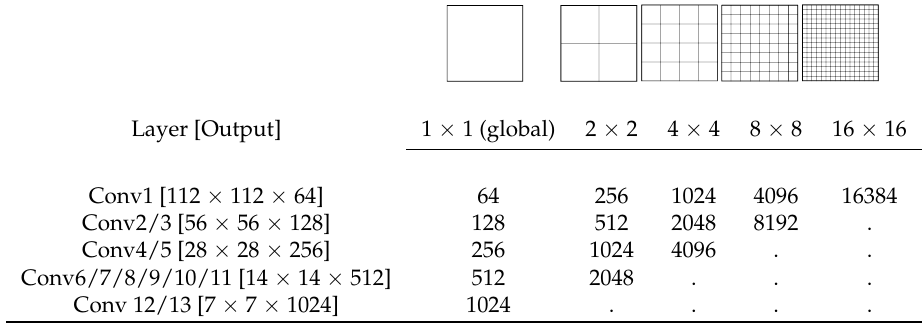
Table 3. Resulting dimensionality of grid pooling strategies on convolutional layers outputs.